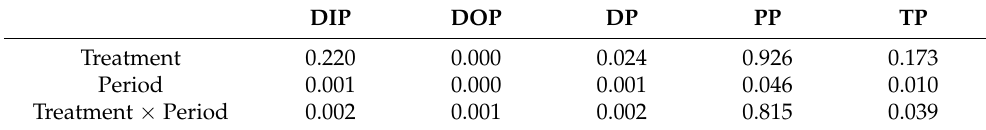
Figure 4. Seasonal variations in percentages of DIP, DOP, and PP in leachate from treatments of CF ( a ), CFS ( b ), and CFSM ( c ). Periods 1–5 indicate the same as those in Figure 2. Table 3. Results ( p values) of two-way ANOVAs on leaching loss of each P form in mollisol. DIP